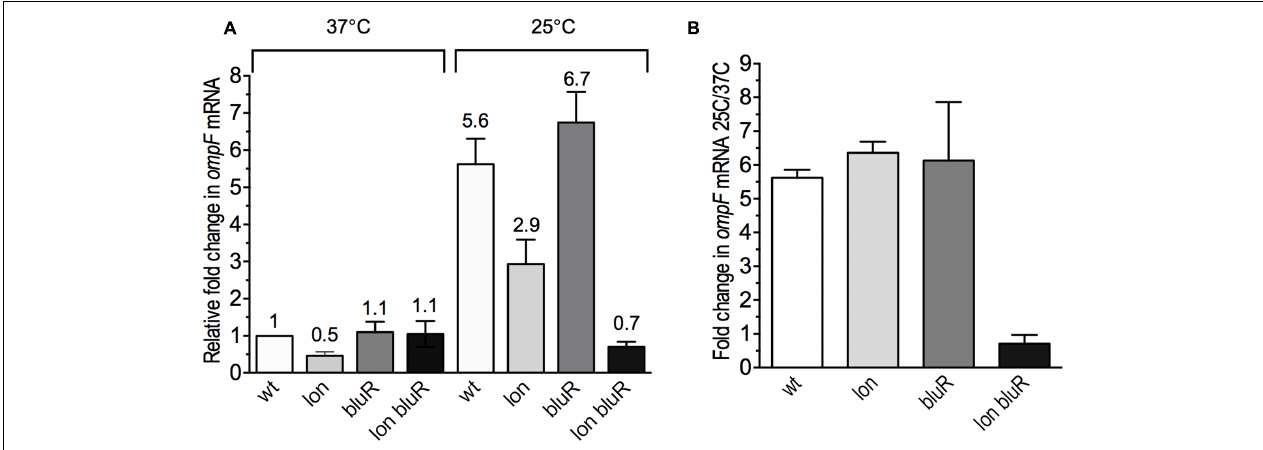
FIGURE 2 | Effect of lon and bluR mutations on ompF mRNA levels in E. coli grown at 25 and 37 ◦ C. The cells were grown to exponential phase (optical density at 600 nm ∼ 0.6) in LB medium. Total RNAs were prepared and used to measure the OmpF mRNA levels by RT-qPCR. (A) Fold change in OmpF mRNA levels relative to the wild type strain AG100 grown at 37 ◦ C. (B) Fold change in OmpF mRNA levels for all strains grown at 25 versus 37 ◦ C. The numbers represent the means and standard deviations of expression levels from three independent experiments performed in duplicate. AG100, wt; M113R, lon ; AGEZ3, bluR ; M113REZ3, lon bluR . See Supplementary Tables S2, S3 for